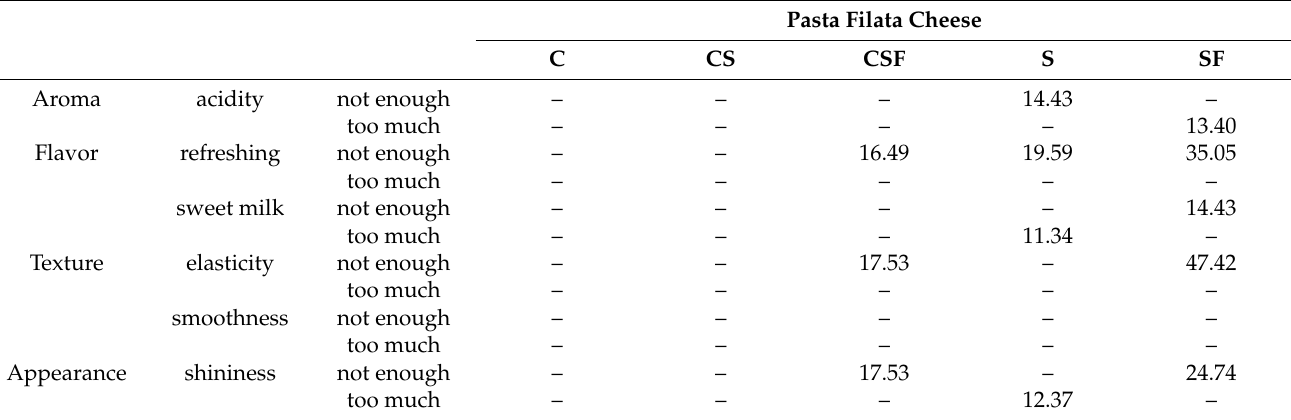
Table 8. Consumer penalty analysis of the just-about-right (JAR) diagnostic attributes of pasta filata cheeses from cow’s and sheep’s frozen